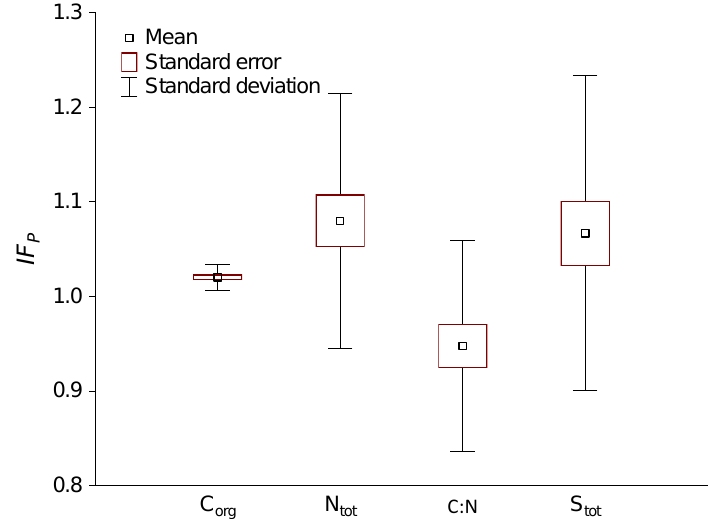
Figure 1. Mean values of petrol effect ( IF P ) on chemical properties in soil uncontaminated with petrol; C org , organic carbon content, N tot , total nitrogen content, C:N, carbon-to-nitrogen ratio, S tot , total sulfur content.